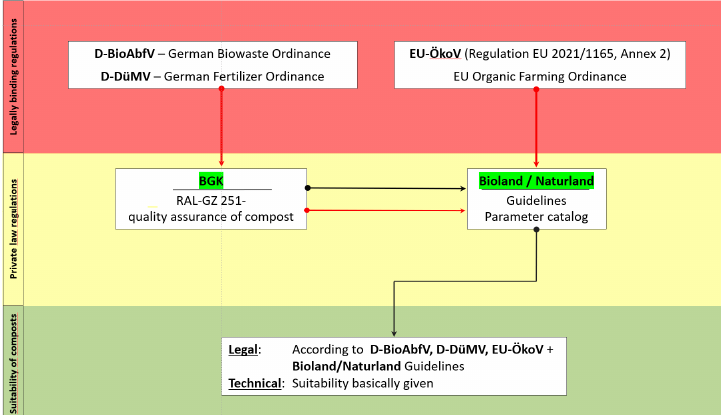
Figure 1. Quality assurance scheme in the determination of suitability of biowaste and green waste composts for use in organic farming in Germany. Applicable legal requirements automatically flow into the private sector guidelines as “co-applicable legal regulations”. / Examination of composts according to listed regulations. Table 1. Parameter catalog of legal (EU-ÖkoV) and private law regulations (directives of Bioland/Naturland) as well as their relevant guideline/limit values for the use of biowaste and green waste composts in organic farming in Germany (1) .